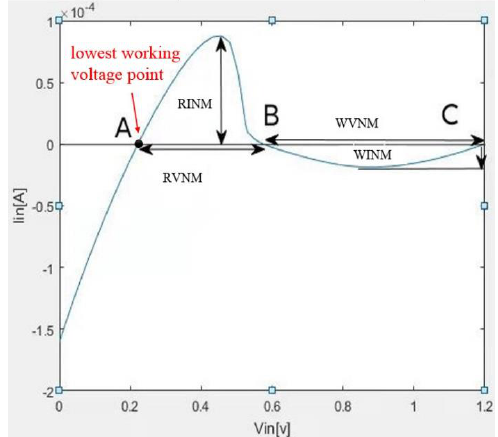
Figure 6. Simulation of stability curve based on leakage current.